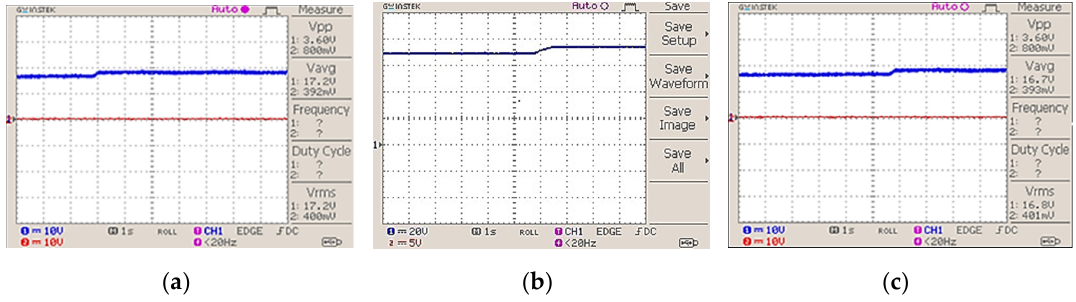
Figure 12. The variation in performance parameters at the photovoltaics (PV) array side: ( a ) the incident irradiation on the photovoltaic array; ( b ) the output voltage; ( c ) the output current.